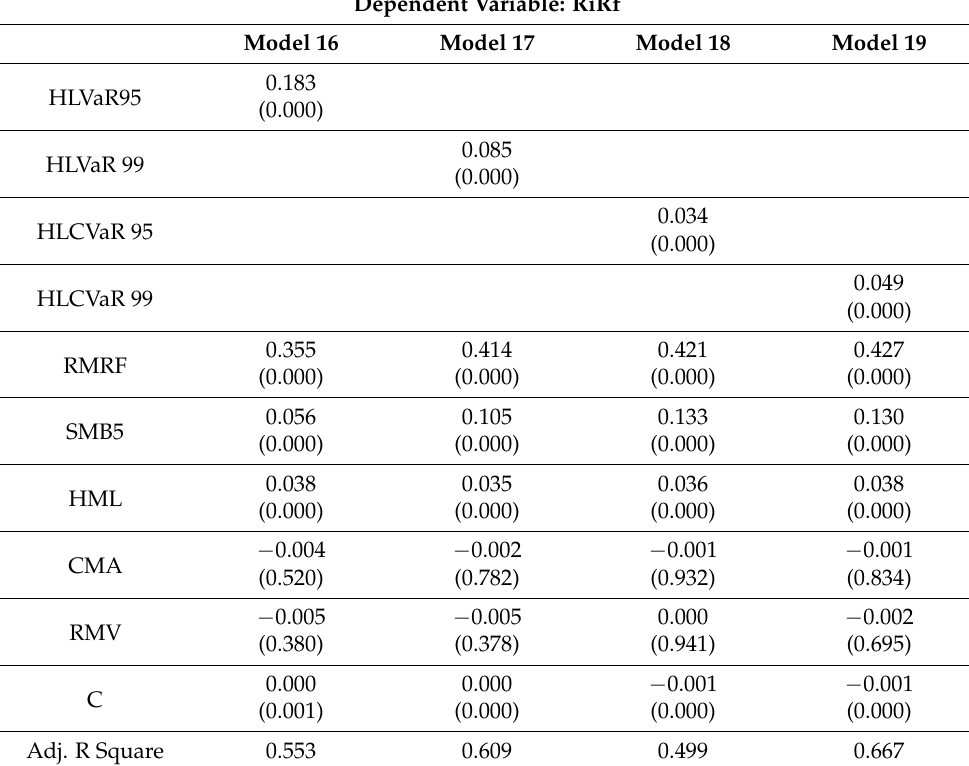
Table 9. Six-factor model. The table represents four models with the dependent variable of excess returns of manufacturing companies listed on the Pakistan Stock Exchange. Independent variables include all systematic risk factors which the study proposed. Market excess return RmRf calculated from the subtraction of KSE 100 Index returns from a risk-free rate of returns. VaR is considered another risk factor with the systematic risk factor in this table. HLVaR subtracts average returns of High VaR portfolio returns from Low VaR portfolio returns. VaR is observed at both 95% and 99% level of significance. HLCVaR represents subtraction of high ES return stocks from low ES returns stocks. SMB provides size factor, HML is a value factor, RMV estimates investment factor represented by CMA and profitability factor. All models give results on the six-factor model. Italic probability value is provided below every coefficient value representing the significance of the coefficient effect dependent